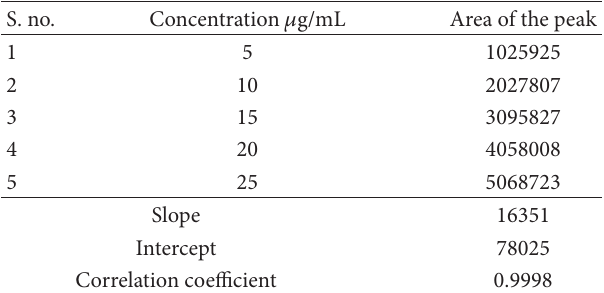
T 3: Linearity of the drug concentration with peak